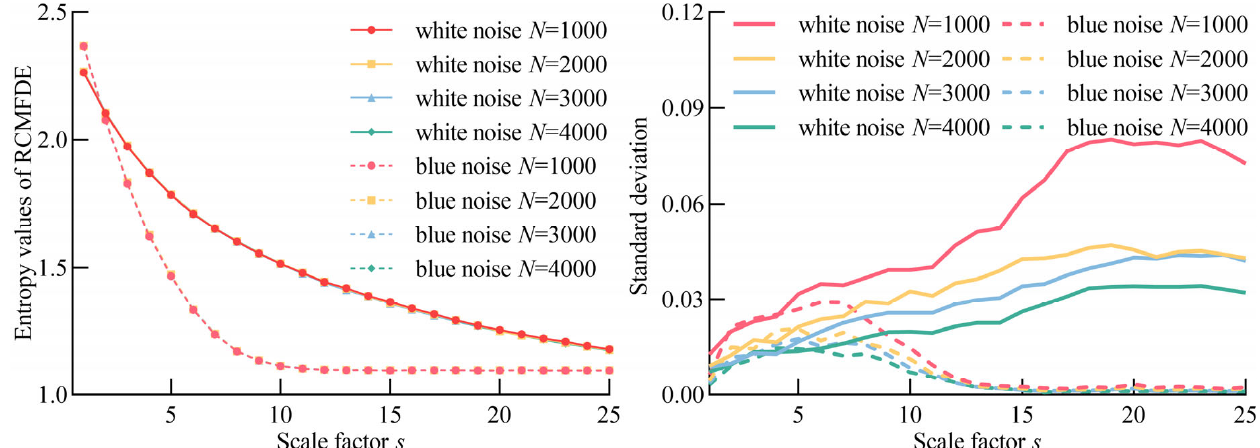
Figure 3. Effect of parameter N on RCMFDE.